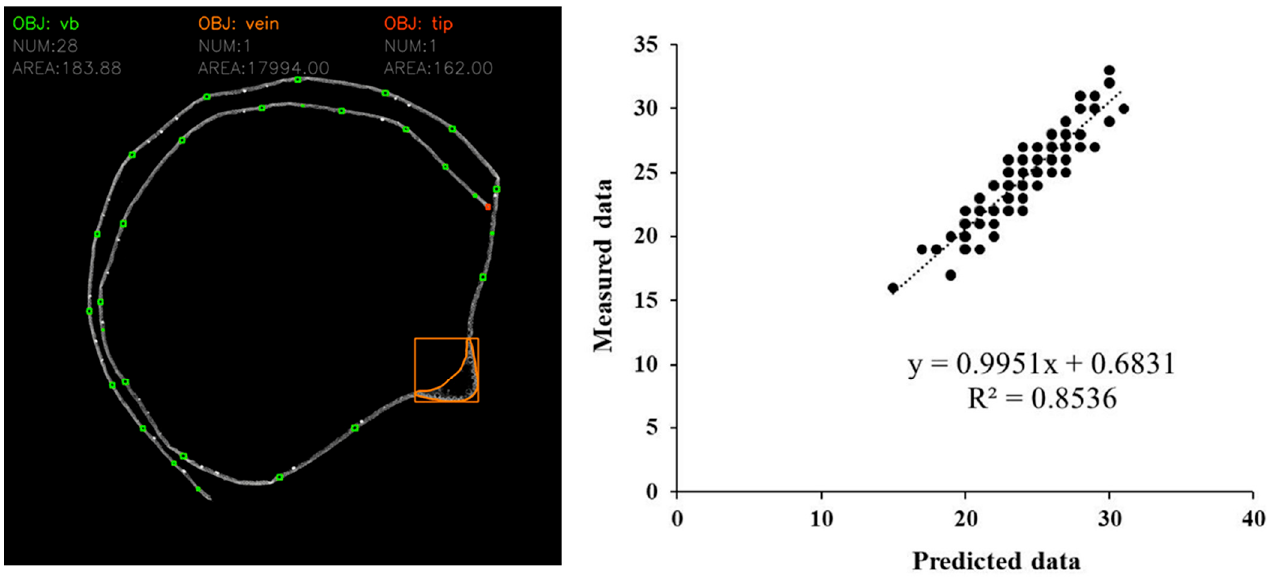
Figure 2. Accuracy evaluation for total number of leaf veins comparing predicted data and meas- ured data.